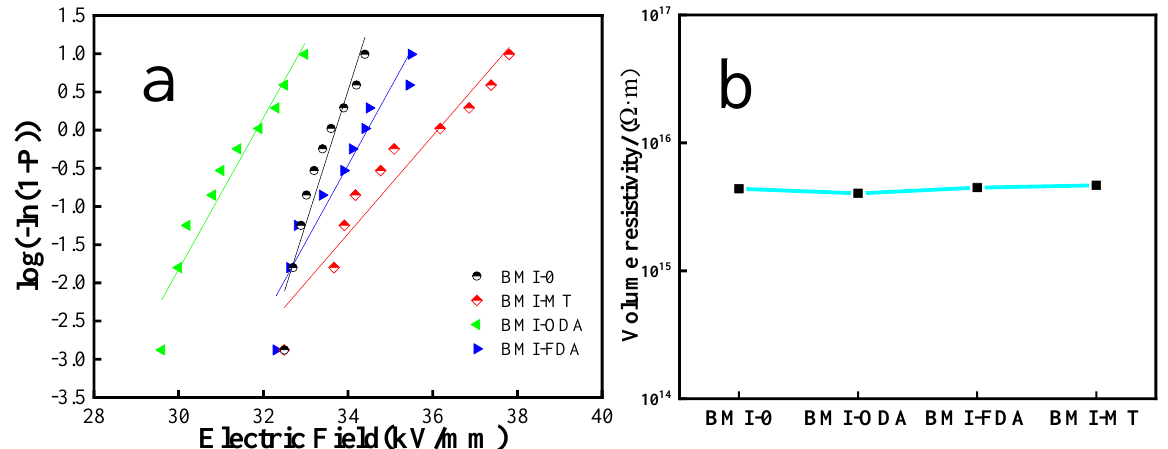
Figure 9. Insulate performance curves of BMI-NH 2 . ( a ) Breakdown strength and ( b ) volume resis- tivity.